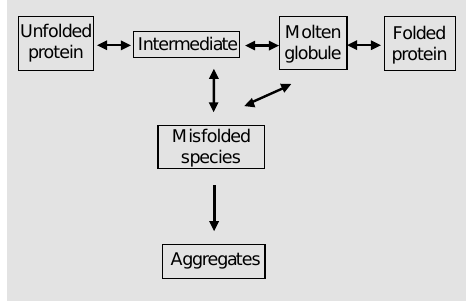
Figure 1 - Illustration of a sche- matic pathway for protein fold- ing with a side reaction and the formation of